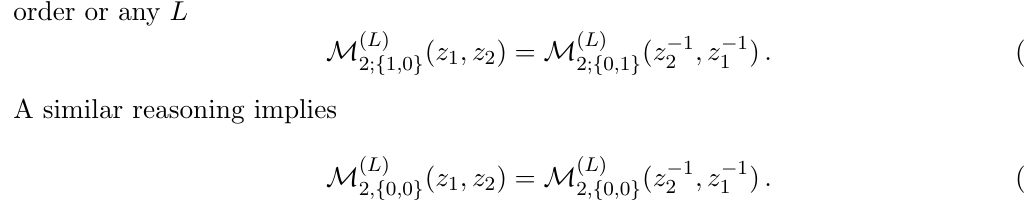
(2) (2) and with nonzero bridges lengths. In 2 ; 1 ; 0 2 ; 0 ; 1 M M f g f g ( L ) ( L ) ( z 1 ; z 2 ) = ( z (cid:0) 1 ; z (cid:0) 1 2 1 2; 1 ; 0 2; 0 ; 1 M M f g f g